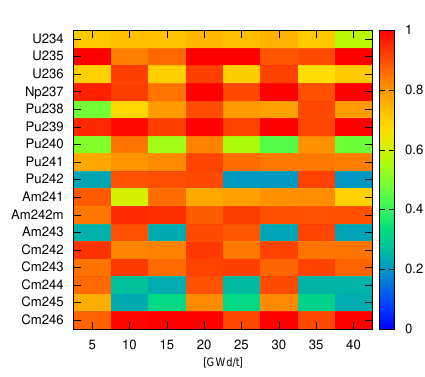
Figure 5. Reduction of RFs when setting individual weights zero (target: k at 40 GWd / t, Case 4) ∞